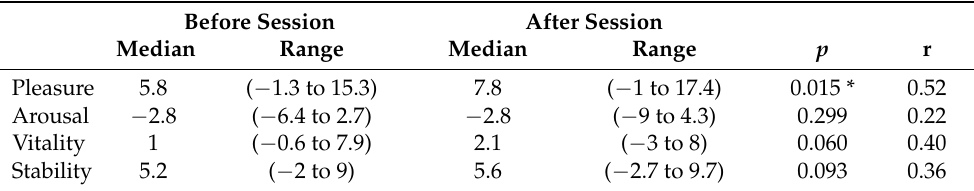
Table 3. Results of average mood scores before and after multiple sessions (n =